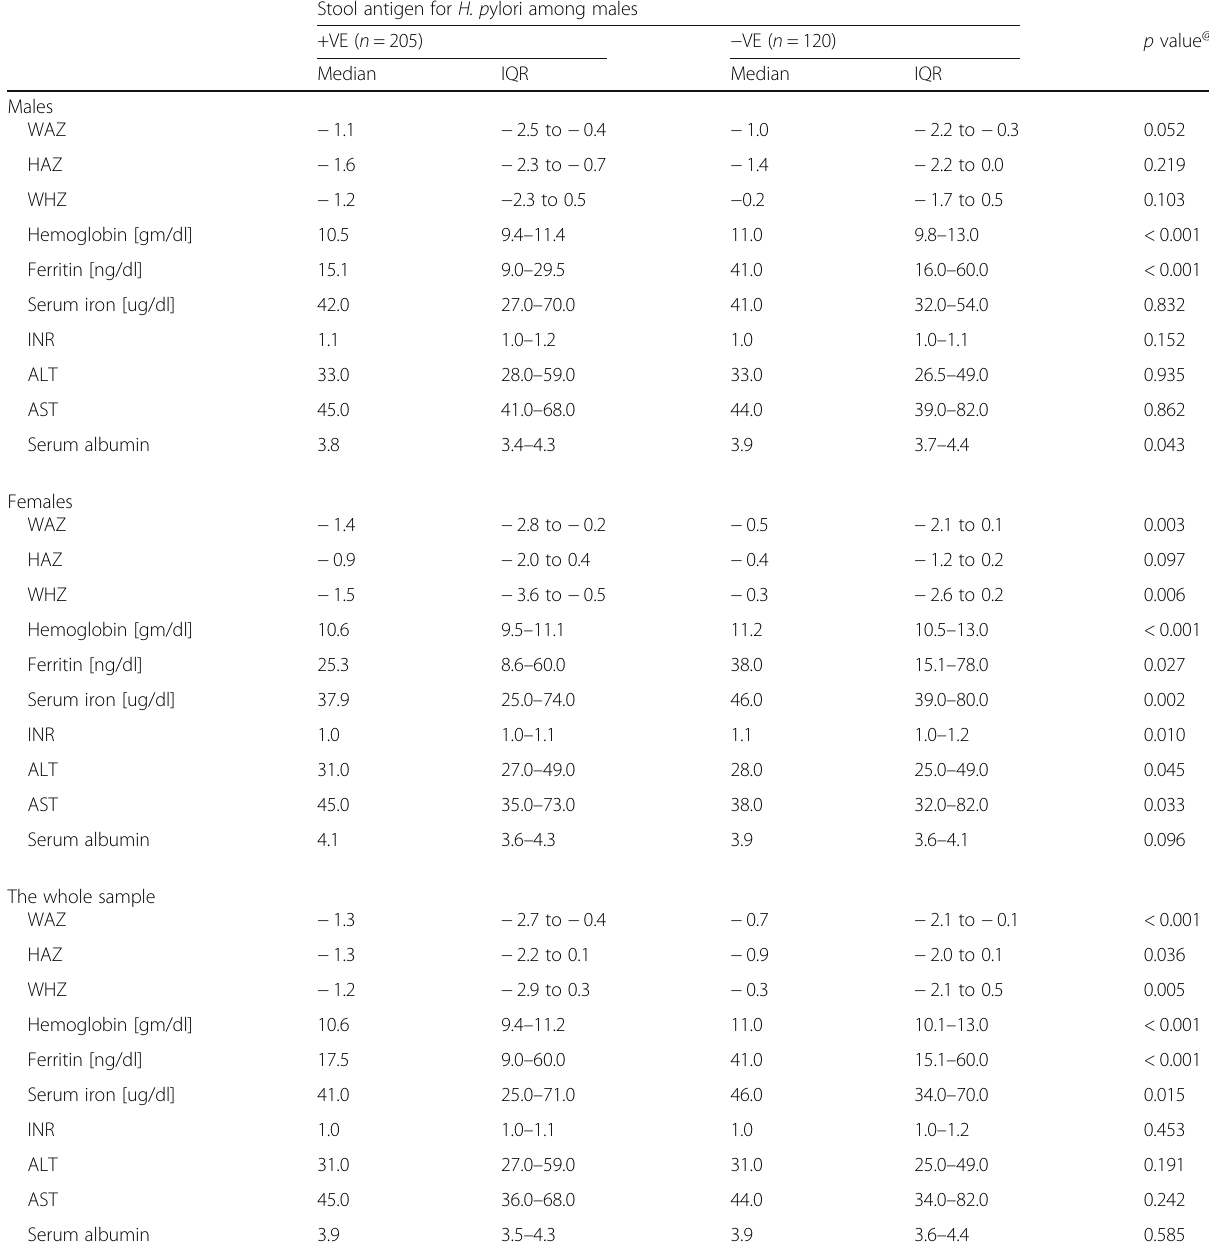
Table 2 Comparison between H. pylori -infected and non-infected symptomatic children regarding anthropometric measurements and laboratory investigations Stool antigen for H. p ylori among